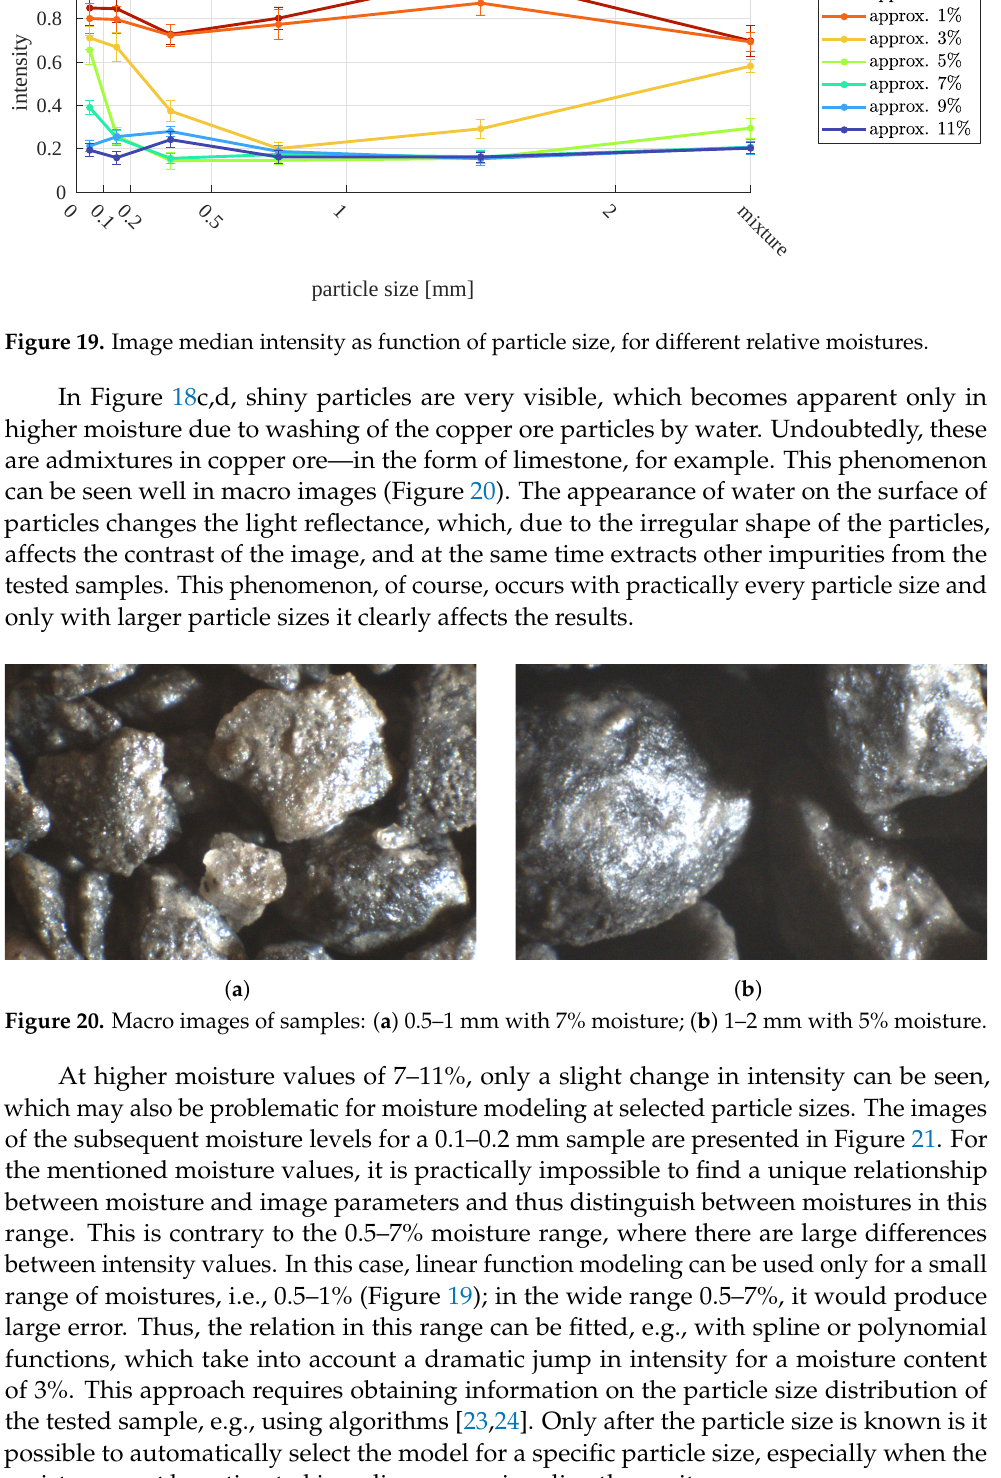
Figure 18. Copper ore samples of 3% moisture, of particle sizes: ( a ) less than 0.1 mm, ( b ) 0.1–0.2 mm,